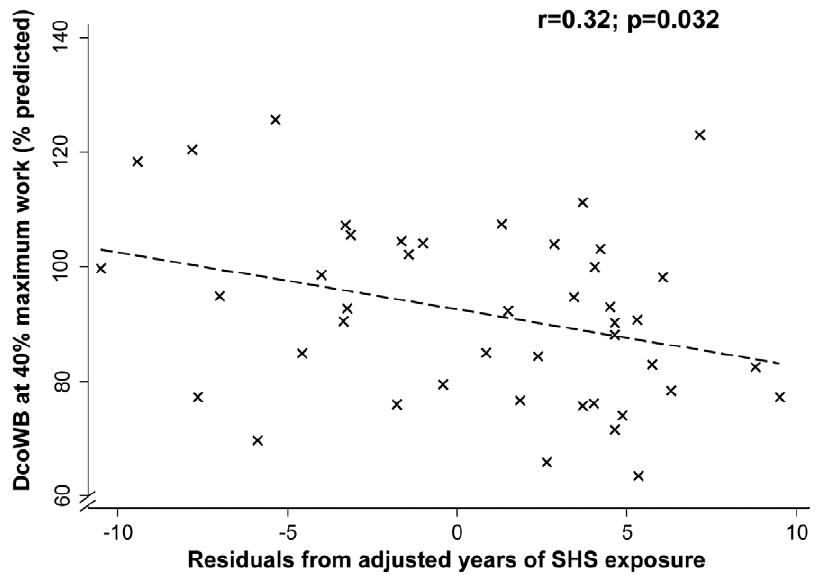
Figure 4. Association between within breath diffusing capacity (DcoWB) during exercise and years of cabin SHS exposure in flight attendants with $ 10 years pre-ban experience (N=42). Percent predicted DcoWB at 40% maximum observed exercise was plotted against the residuals of adjusted pre-ban years employment. r: correlation coefficient.